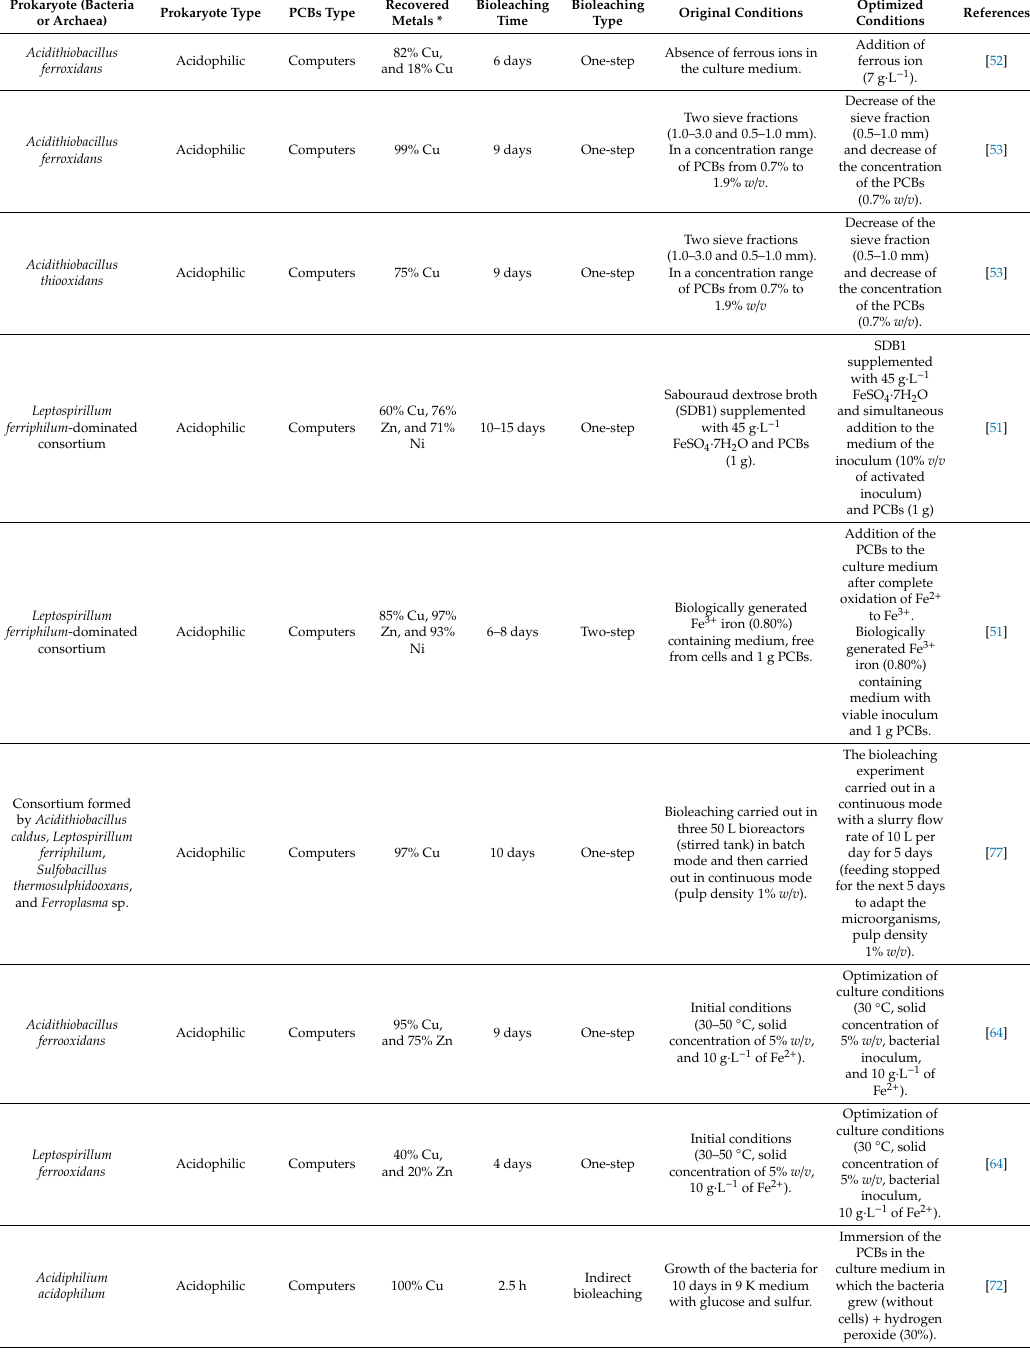
Table 2. Prokaryotes used in the recovery of metals from printed circuit boards (PCBs) of computers and cell